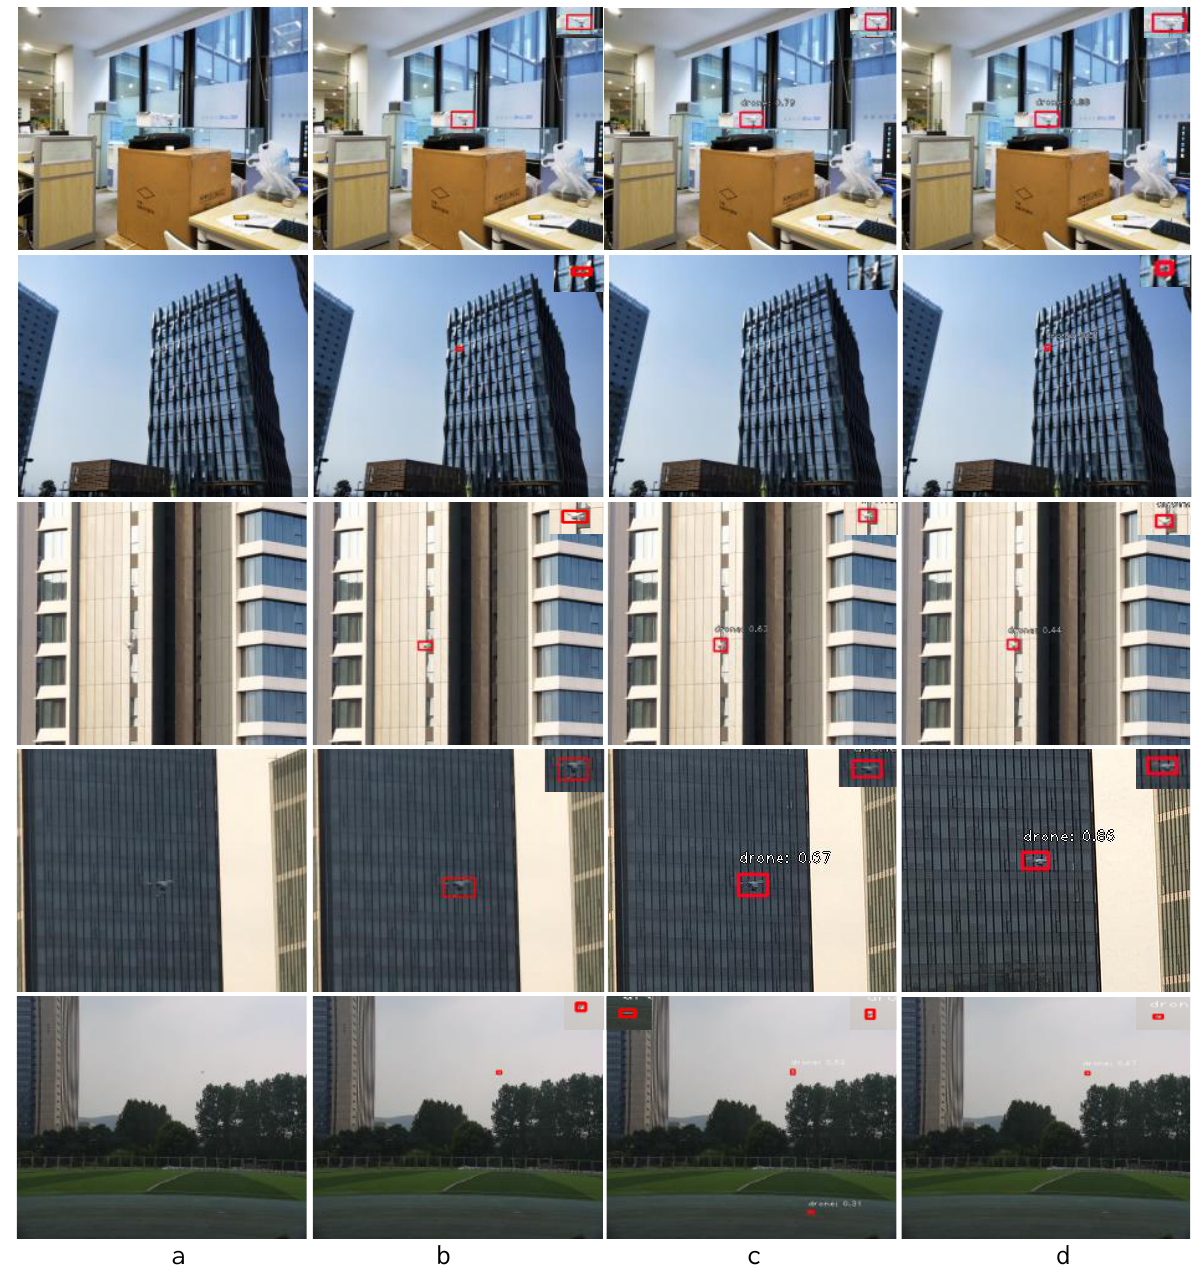
a b c d Figure 9. Detection results: ( a ) Original images; ( b ) ground truth; ( c ) detection result of MFACN; and ( d ) detection result of